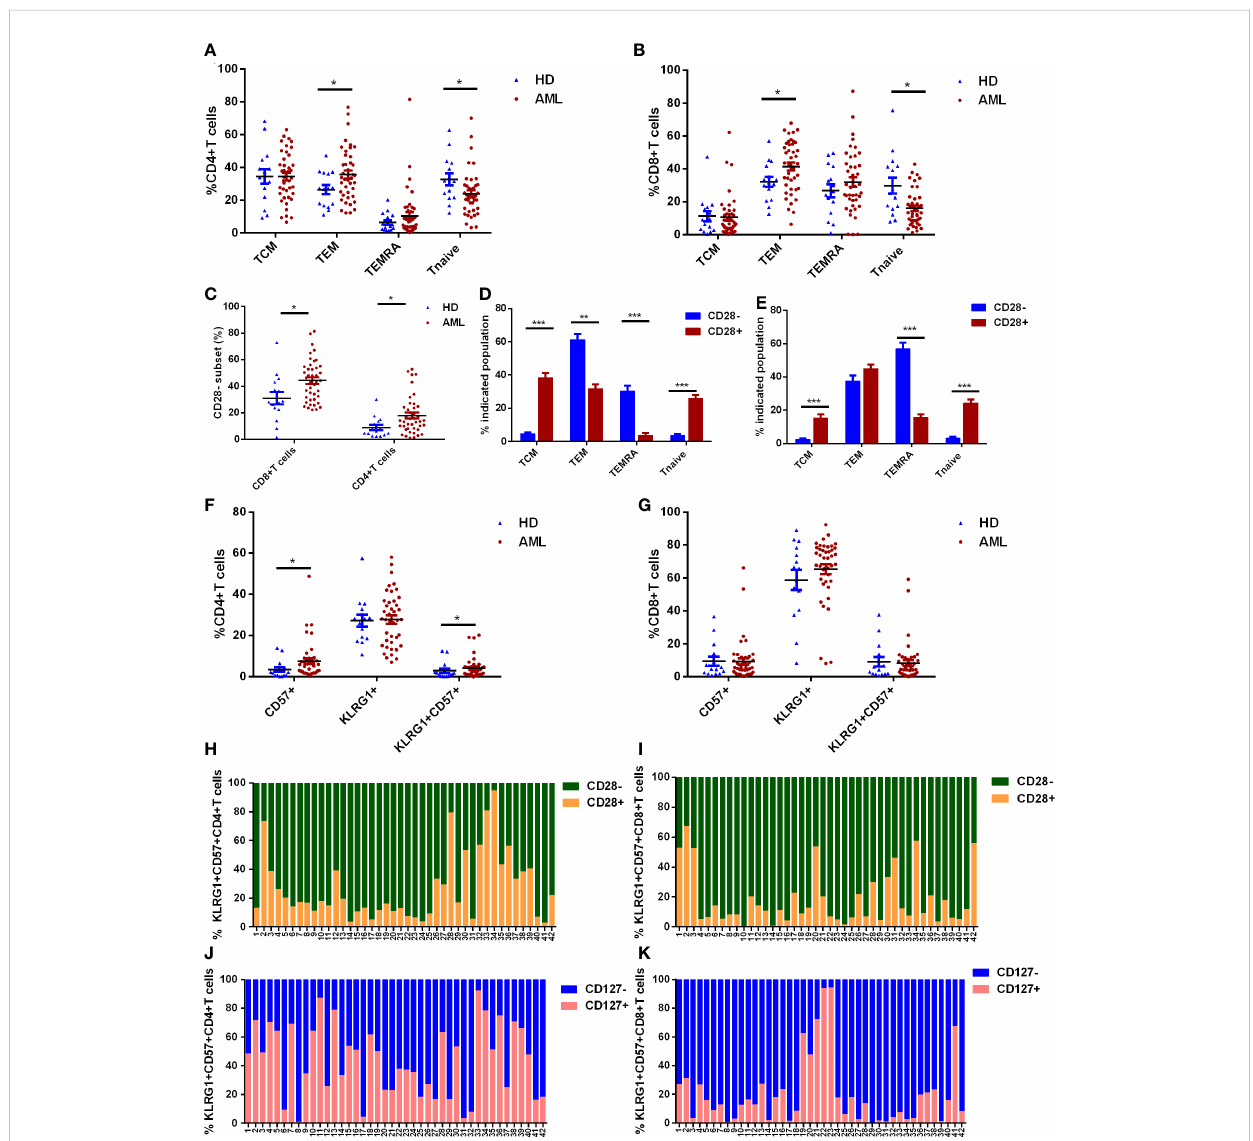
FIGURE 1 T cell differentiation and expression of senescent markers on T cells in de novo AML patients (n=42) and healthy donors (HDs, n=15). (A, B) The frequencies of naïve T cells (Tnaive, CCR7 + CD45RA + ), central memory T cells (TCM, CCR7 + CD45RA - ), effector memory T cells (TEM, CCR7 - CD45RA - ) and effector memory T cells with expression of CD45RA (TEMRA, CCR7 - CD45RA + ) de fi ned by CCR7 and CD45RA in CD4 + (A) and CD8 + (B) T cells from bone marrow (BM) were compared in de novo AML and HDs. Additionally, the percentages of CD28 - subset in CD4 + and CD8 + T cells from BM of de novo AML and HDs were evaluated (C) . The differentiated status was further analyzed in CD28 - and CD28 + subset of CD4 + (D) and CD8 + T cells (E) . Senescent markers: CD57 and KLRG-1 expression on CD4 + (F) and CD8 + T cells (G) in BM were compared between AML patients and HDs. At last, CD28 expression in KLRG-1 + CD57 + subset in CD4 + T cells (H) and CD8 + T cells (I) and CD127 expression in KLRG-1 + CD57 + subset in CD4 + T cells (J) and CD8 + T cells (K) were analyzed in de novo AML patients. Student ’ s t test or Mann-Whitney U test was used to analyze the data according to normal distribution of data. *, ** and *** indicated p-values between 0.01 to 0.05, 0.001 to 0.01 and 0.0001 to 0.001,